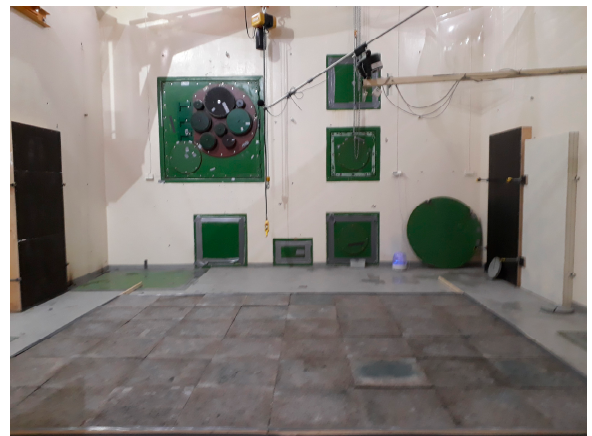
Figure 6. The panels installed onto the reverberation chamber floor.